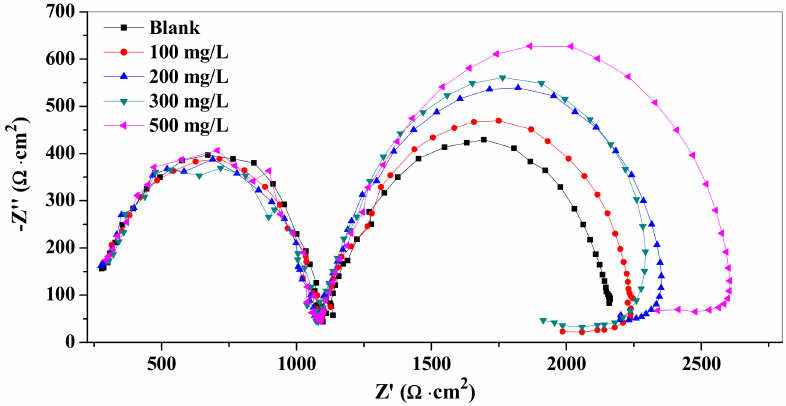
Figure 6. Nyquist plots for carbon steel in the absence and presence of di ff erent concentrations of TPP at 25 ◦